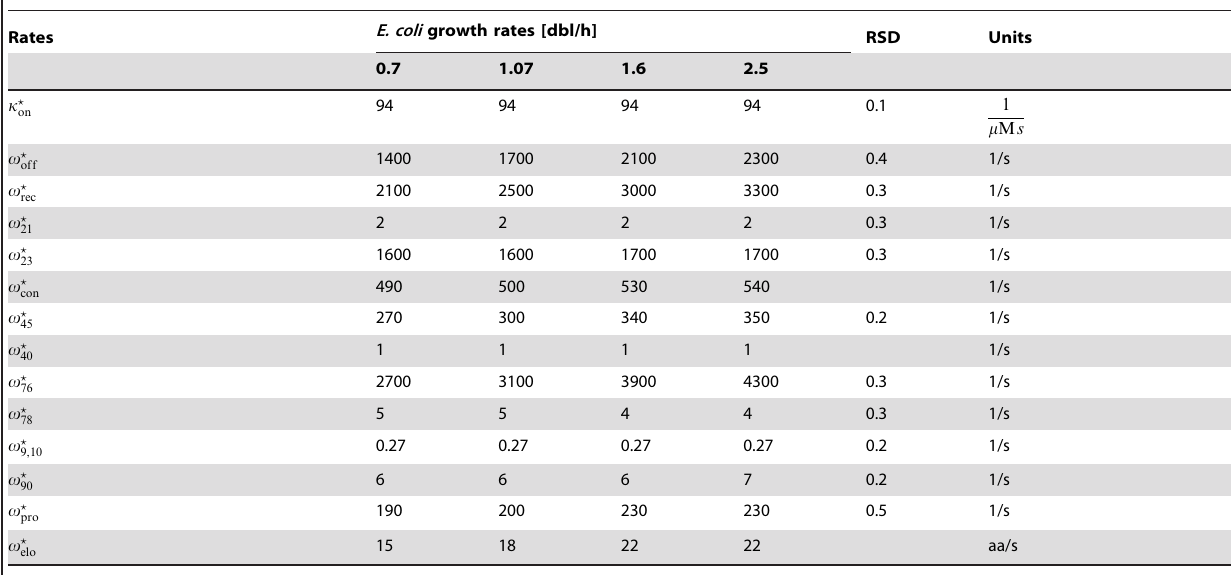
The values of the overall elongation rate v ? elo for the four growth conditions 0.7, 1.07, 1.6, and 2.5 dbl/h were obtained from the data in Ref. [27]. These growth conditions have been chosen because, for these conditions, the total tRNA concentrations have been measured as well in Ref. [28]. The relative standard deviations (RSDs) in the sixth column were obtained from the errors of the in-vitro rates in Table 1, and from the associated changes in the predicted in-vivo point, see Methods section.